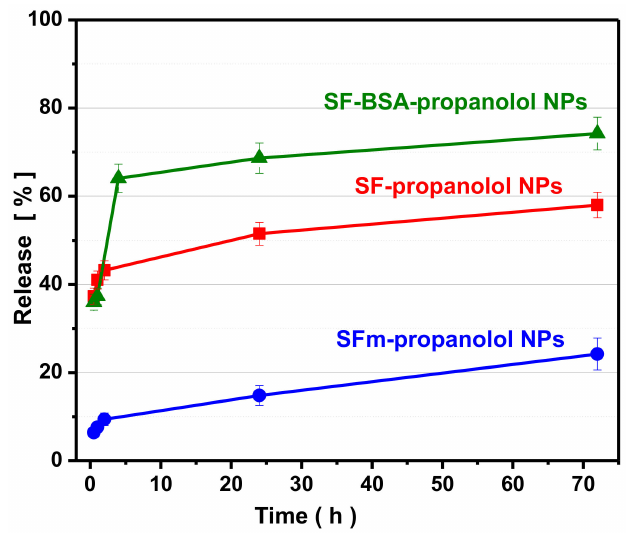
Figure 8. Drug release rate of fibroin nanoparticles, magnetic fibroin nanoparticles, and fibroin–bovine serum albumin nanoparticles encapsulated with